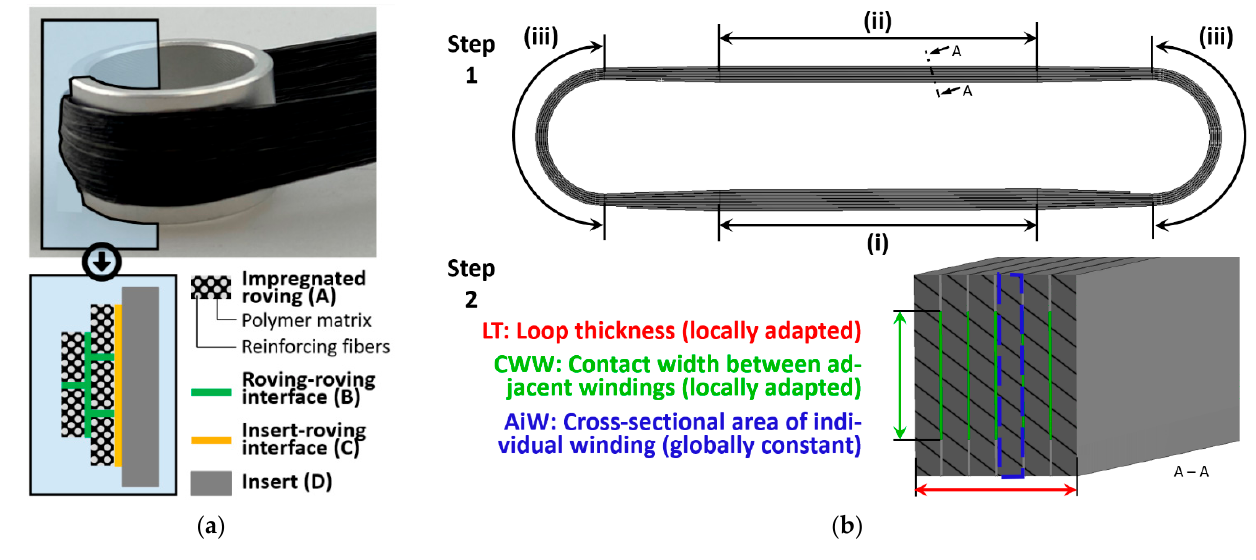
Figure 1. ( a ) Structural constituents within fiber skeletons, adapted from [21]; ( b ) Distinction of characteristic areas in a simple loop (shafts (i, ii) and wraps (iii)) and definition of characteristic dimensions, adapted from